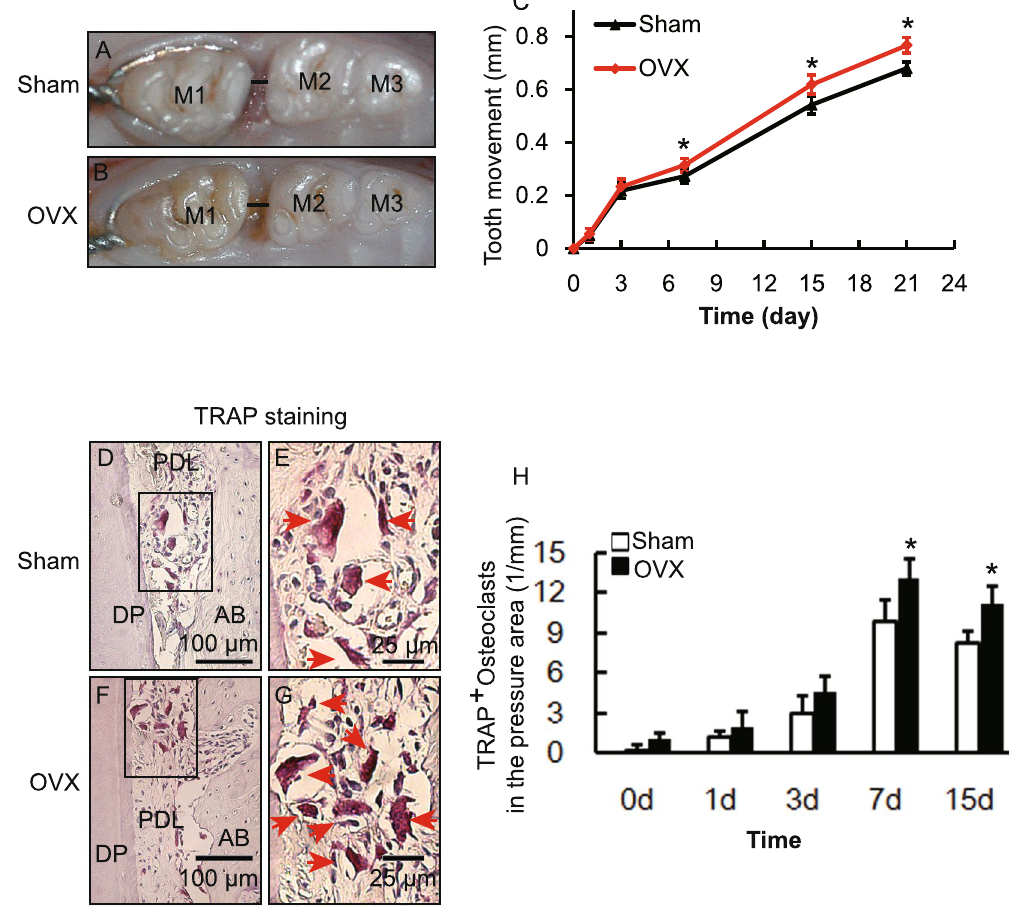
Figure 1. Ovariectomy increased OTM and bone resorption during OTM in OVX rats. ( A , B ) Representative images of tooth movement on day 21 of OTM in Sham and OVX rats. M1, the left maxillary first molar; M2, the left maxillary second molar; M3 the left maxillary third molar; the distance of OTM is indicated by a black line. ( C ) Effect of ovariectomy on the rate of OTM. Data represent means ± S.D. * P < 0.05, n = 6. ( D – G ) Representative images of TRAP staining in the pressure area on day 7 of OTM in Sham and OVX rats. E and G are high-magnification images of the squares in D and F respectively. AB, alveolar bone; DP, disto-palatal root; PDL, periodontal ligament; P, pressure area; T, tension area. ( H ) TRAP-positive osteoclasts in the pressure area during OTM in Sham and OVX rats. Data represent means ± S.D. * P < 0.05, n =